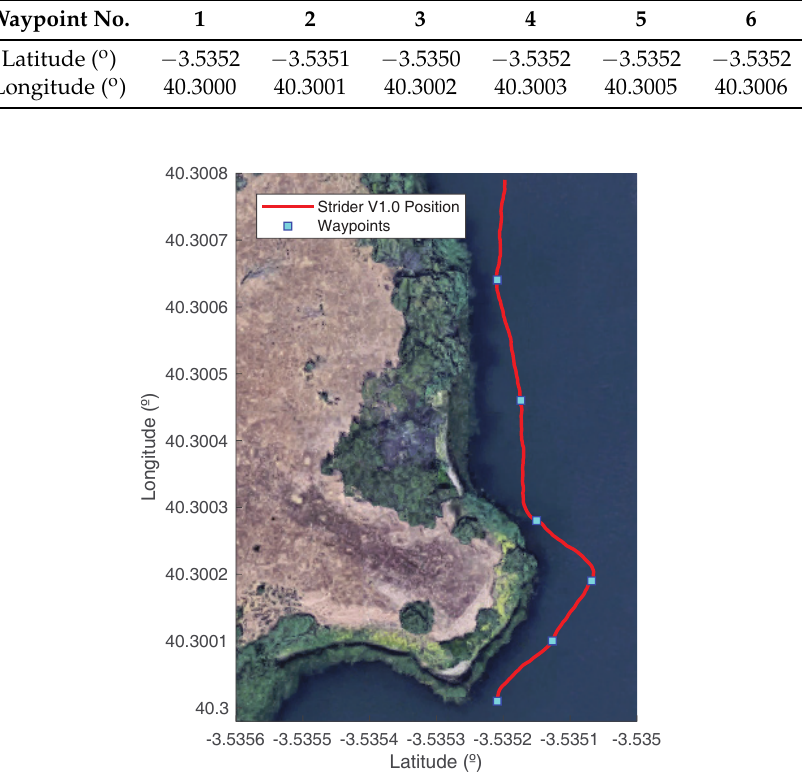
Figure 18. The figure illustrates the trajectory followed by the vessel during the waypoint tracking test. The starting waypoint is the southernmost. The map and coordinates correspond to a testing area for the Strider